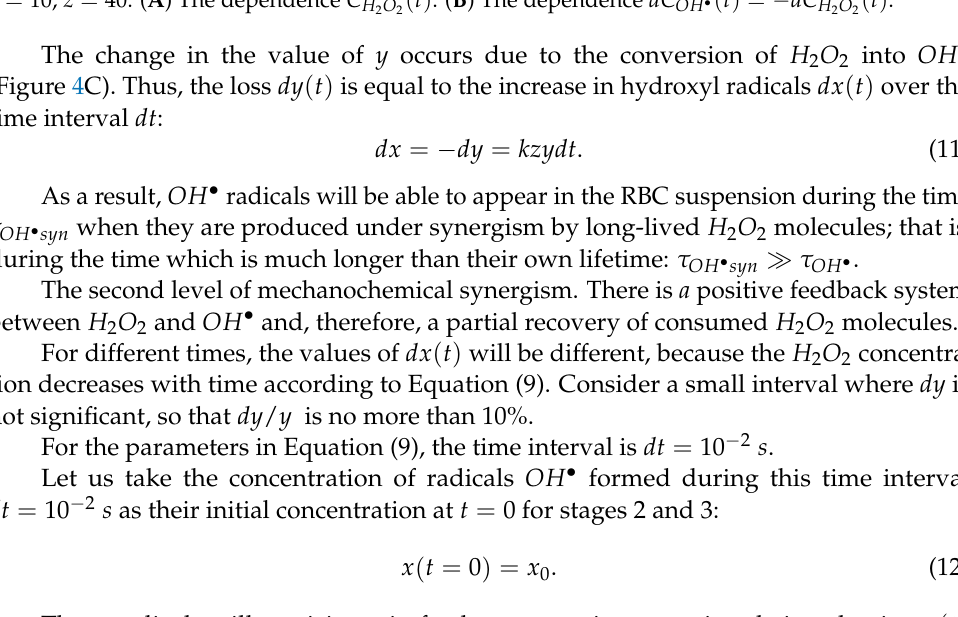
( t ) = − dC ( t ) ( t ) . ( B ) The dependence dC (𝑡) . ( B ) The dependence 𝑑𝐶 (cid:3016)(cid:3009) • (𝑡) = −𝑑𝐶 (cid:3009) (𝑡) . H 2 O 2 OH • 2 O 2 (cid:3118) (cid:3016) (cid:3118) (cid:3118) (cid:3016) (cid:3118)